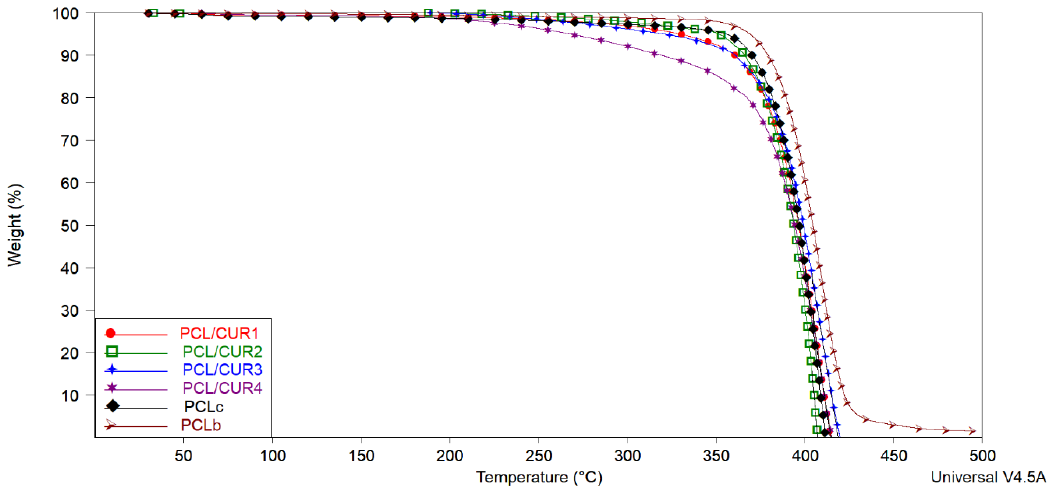
Figure 5. The TGA spectra of PCL/CUR scaffolds. PCL: poly (caprolactone). CUR: Curcumin. PCLc: PCL control fibers. PCLb: PCL beads.